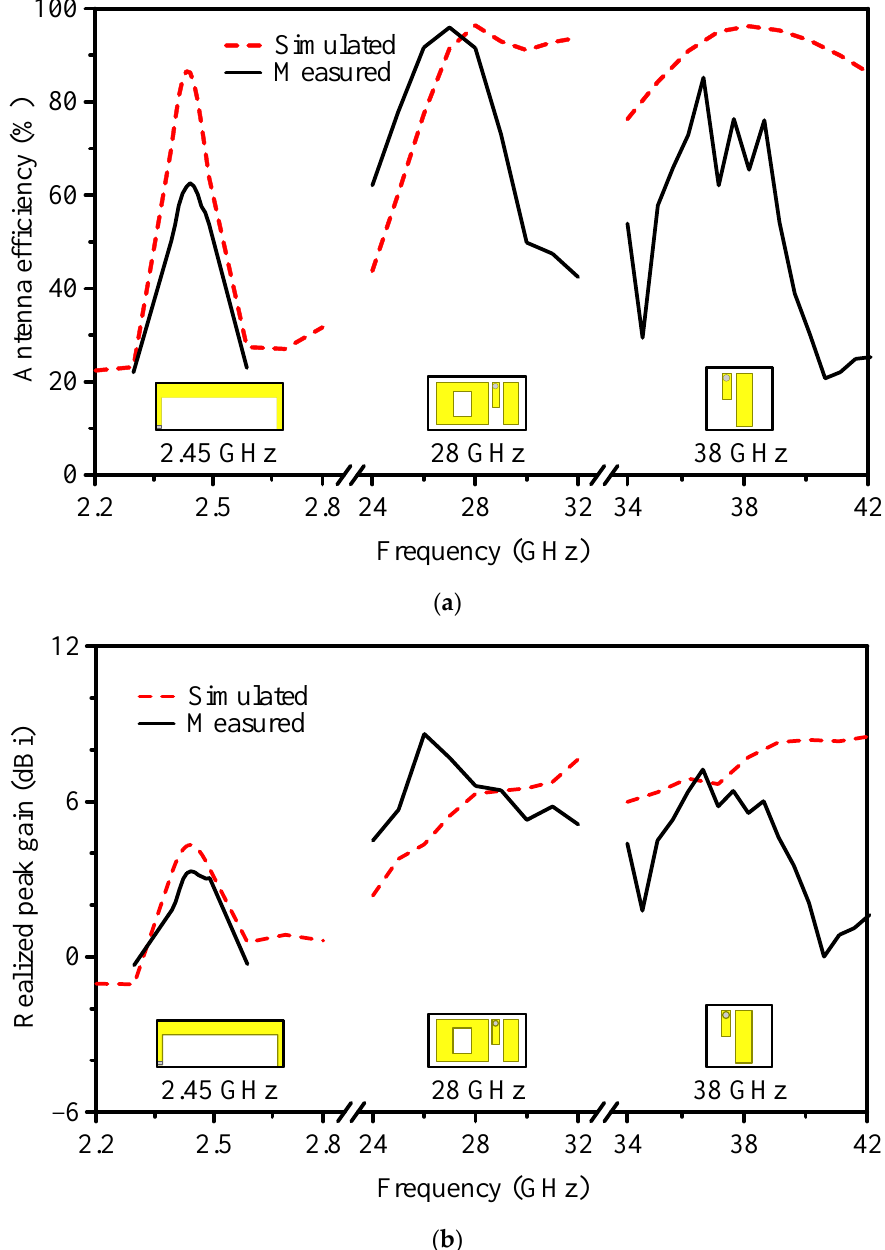
Figure 9. ( a ) Antenna efficiency and ( b ) realized peak gain for the 28 GHz unit element, 38 GHz unit element, and 2.45 GHz loop antenna.